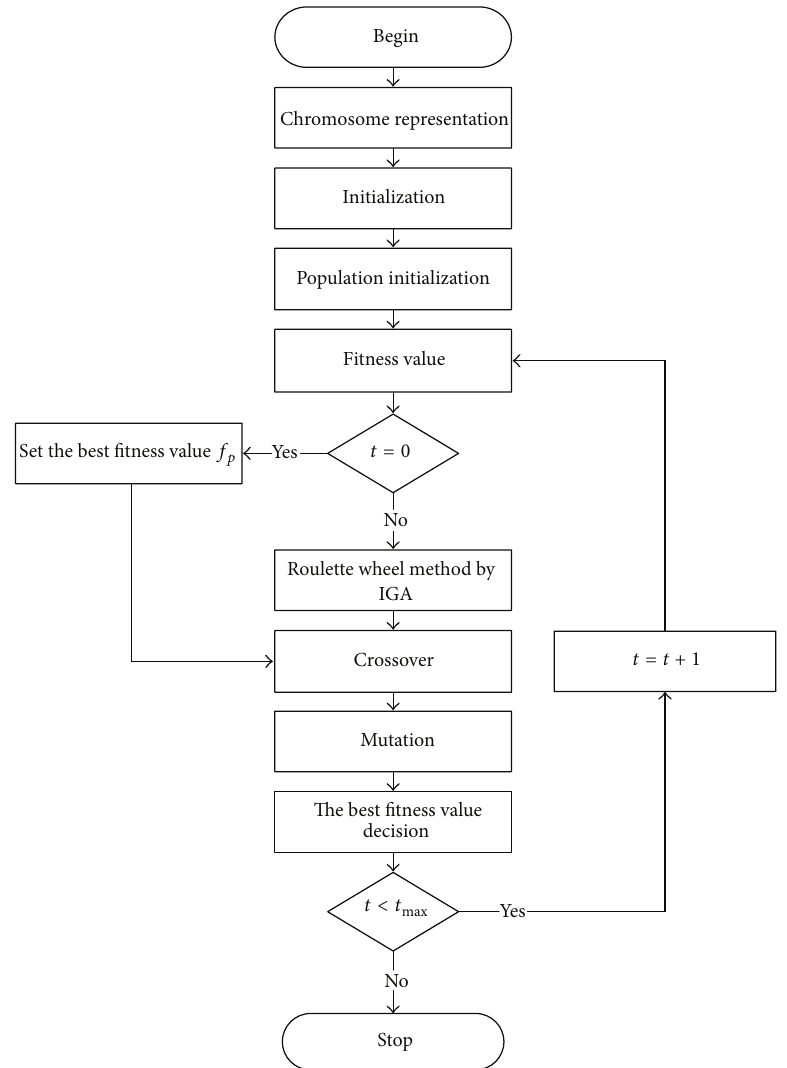
Figure 5: Flow chart of the Immune Genetic Algorithm